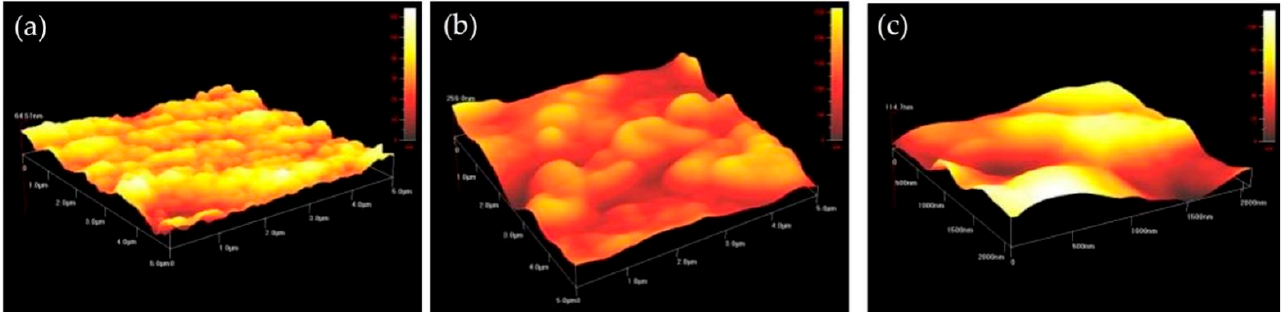
Figure 12. AFM images of different sizes of TiO 2 NPs attained from ( a ) Bacillus subtilis [79], ( b ) Cassia fistula , and ( c ) hydrothermal heating [80].